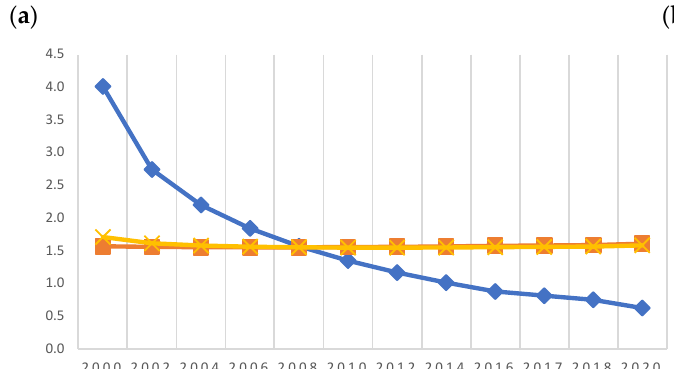
Figure 1. Visualization of energy efficiency ecological indicators σ -convergence assessment. Note: ( a ) in terms of CO 2 emissions per capita; ( b ) by ozone concentration; ( c ) by the amount of waste generated. The ordinate axis is units; abscissa — years; blue line — Ukraine, orange line — EU countries, yellow line — Ukraine and EU countries.